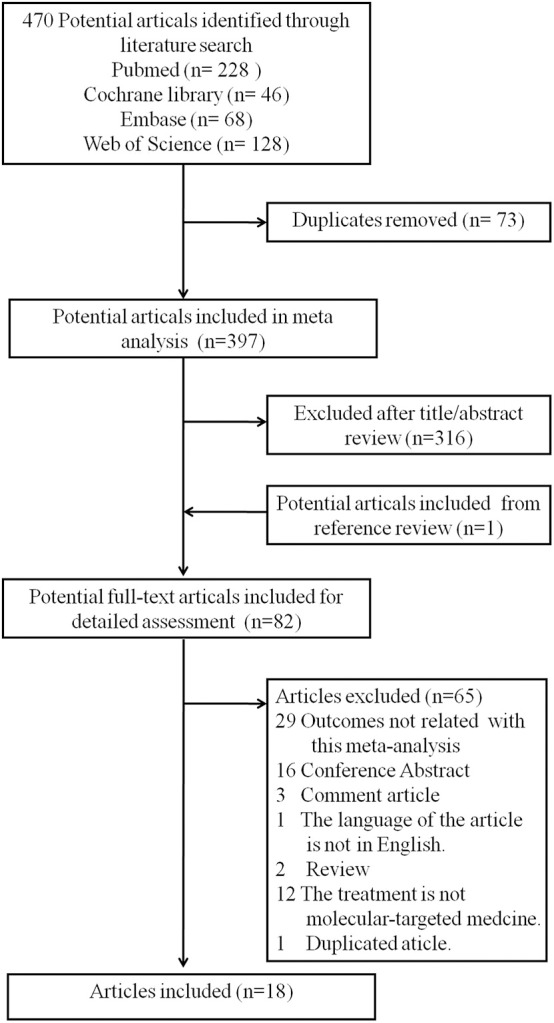
Flow diagram of the literature search and studies inclusion.